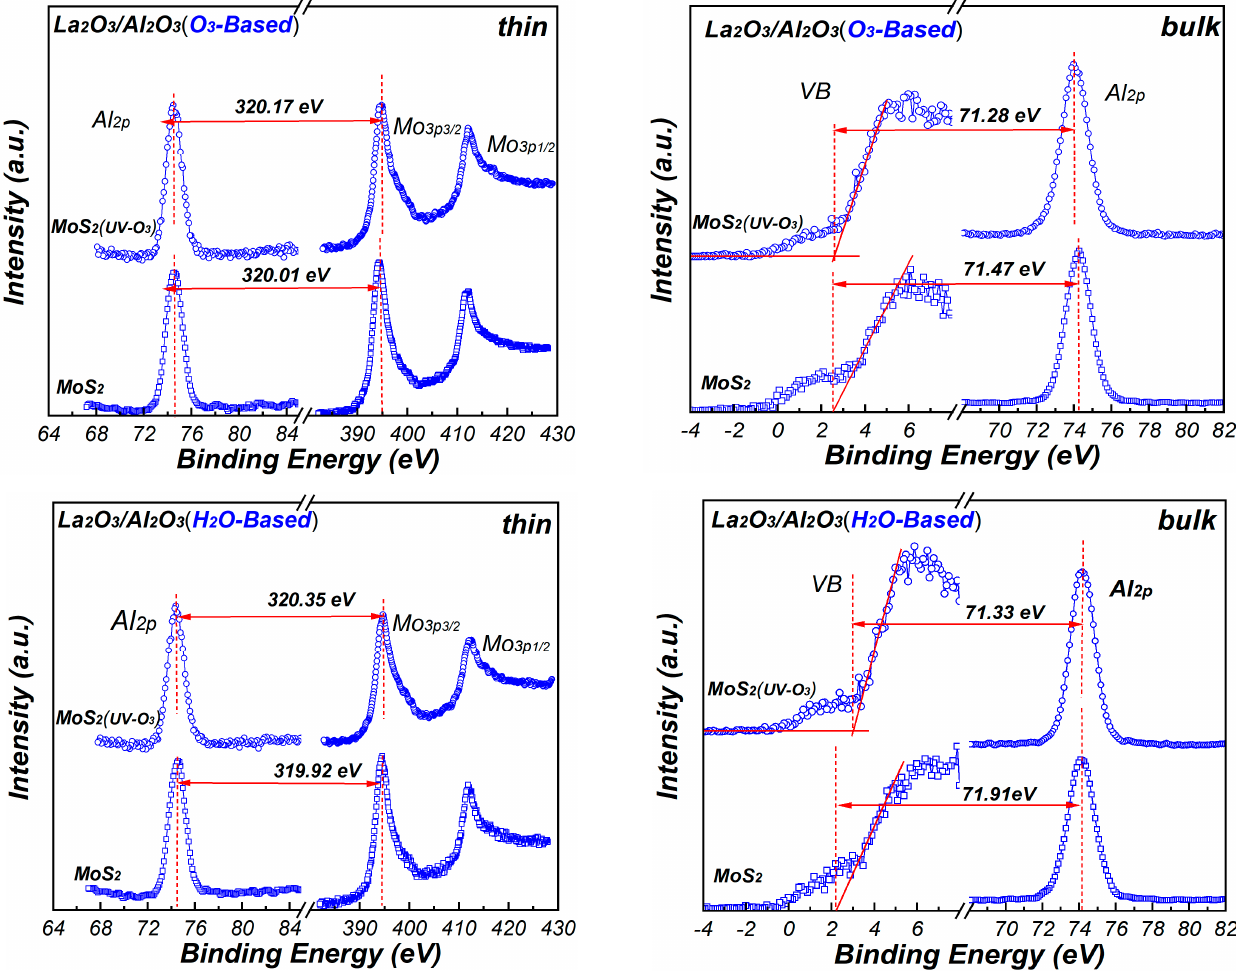
8 of 13 Figure 6. The XPS core level spectra of Mo 3p for MoS 2 . Figure 7 shows the XPS core level spectra of Mo 3p and Al 2p for La 2 O 3 /Al 2 O 3 nano- laminates. The core level energies are obtained by curve fitting to ensure high accuracy binding energy of the peak. In order to measure the band offset between La 2 O 3 /Al 2 O 3 nan- olaminates and MoS 2 , ~10 nm H 2 O-based and O 3 -based La 2 O 3 /Al 2 O 3 nanolaminates are prepared for use as bulk films, respectively. As shown in Figure 7, the energy difference values between the core level energies are determined. Using these energy difference val- ues with Equation (1), the VBO values of the H 2 O-based and O 3 -based La 2 O 3 /Al 2 O 3 nano- laminates on MoS 2 can be derived. The VBO of 3.10 eV and 3.14 eV is obtained for O 3 -